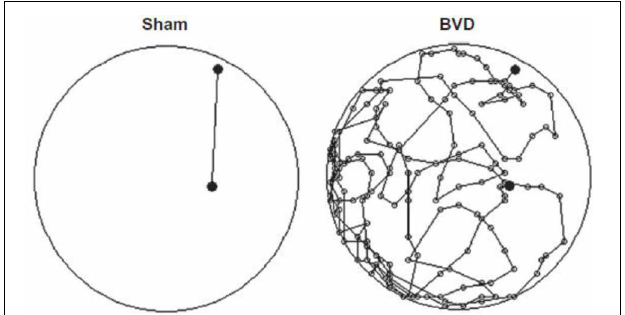
FIGURE 6 | An example of a homeward path taken by a BVD rat and a sham control rat at 14 months post-op. during a foraging task in darkness in which animals had been trained to forage for food and navigate their way back to a home base. Whereas the Sham rat traveled